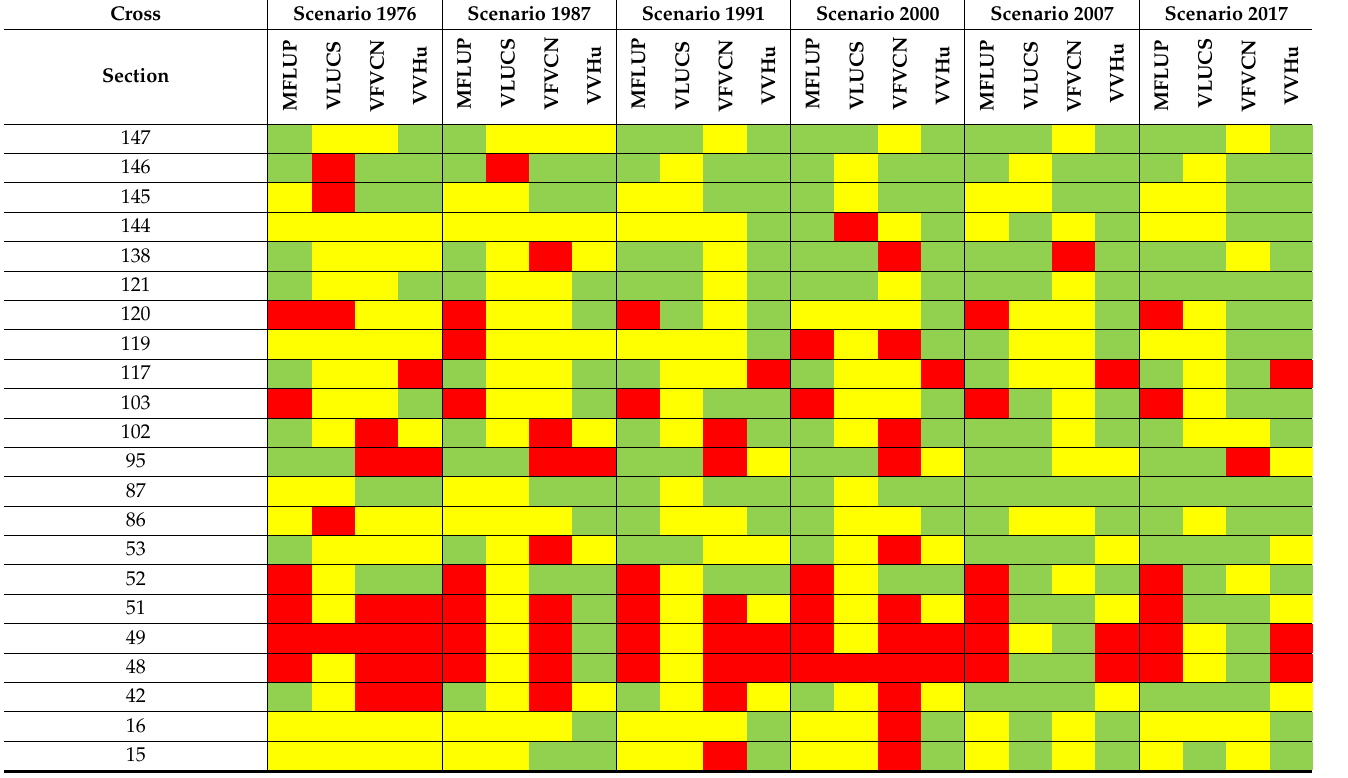
Table 3. Variation of physical vulnerability in the land-use change scenarios evaluated per